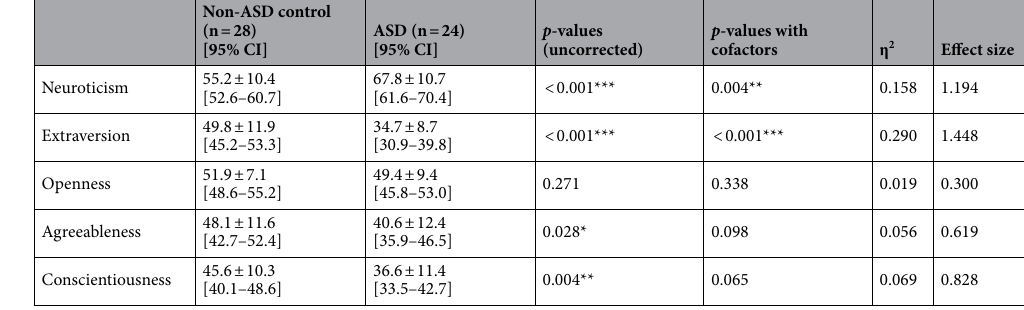
Table 4. Personality data on the NEO. Data are mean ± SD. The number in the bracket is the value of 95% confidence intervals (CI). η 2 semi-partial eta-squared. Effect size represents a sample-based estimate of the quality. NEO NEO Personality Inventory-Revised. * p < 0.05,** p < 0.01,*** p < 0.001. Uncorrected p -values are determined by MANOVA followed by t -tests. Corrected p values were done by subsequent ANCOVA, treating BDI ad full-scale IQ scores as covariates.